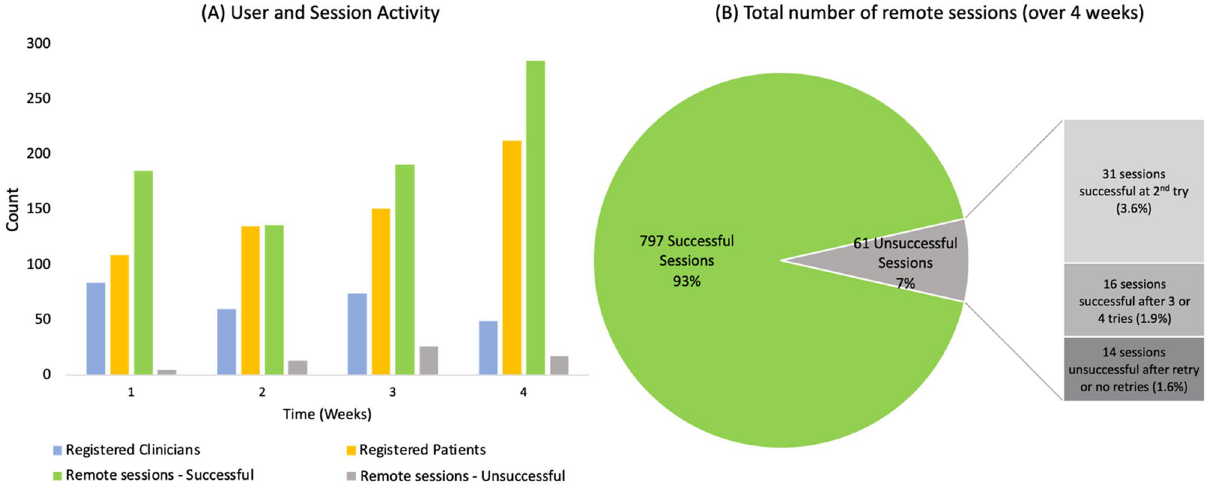
Figure 5. User analytics and session quality data from 4-week preliminary experience during the limited marker release of the remote care platform. ( A ) Representation of registered clinicians and patients in the user portal and the number of remote connections. ( B ) Number of successful and unsuccessful remote session connections with a breakdown of retry status.